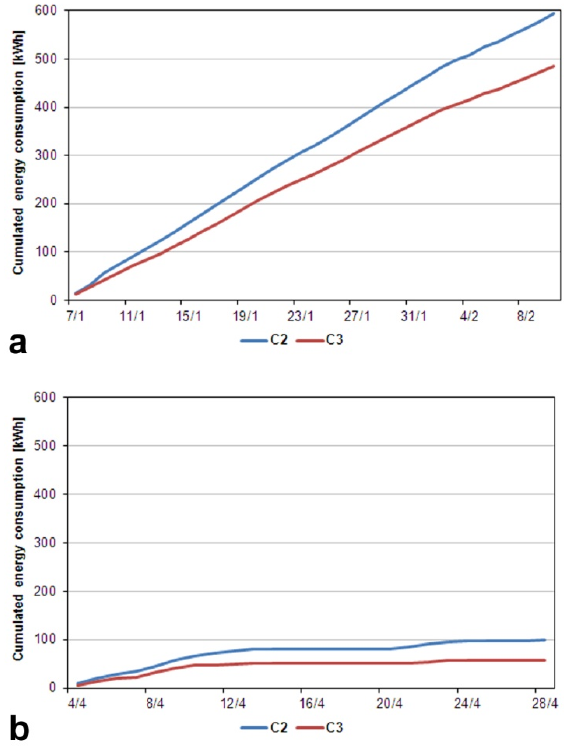
Figure 6. Cumulated consumption: ( a ) configuration “a” of Table 2; ( b ) configuration “b” of Table 2.